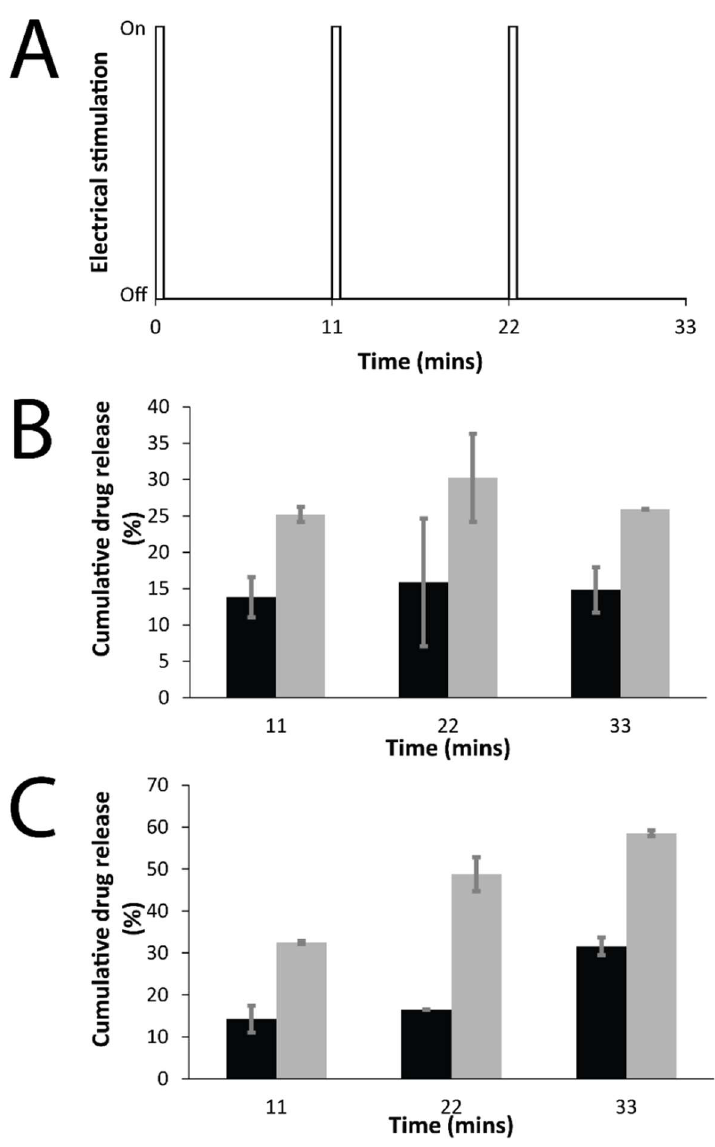
Figure 9. Electrochemically enhanced delivery of drugs from films in PBS (pH = 7.4) as determined by UV spectroscopy: ( A ) Electrical stimulation paradigm: three cycles of 30 s on, 10.5 min off; ( B ) cumulative release of DMP from DMP-doped PPY films, passive release (black bars), electrically stimulated release (gray bars); ( C ) cumulative release of MER from MER-doped PPY films, passive release (black bars), electrically stimulated release (gray bars).